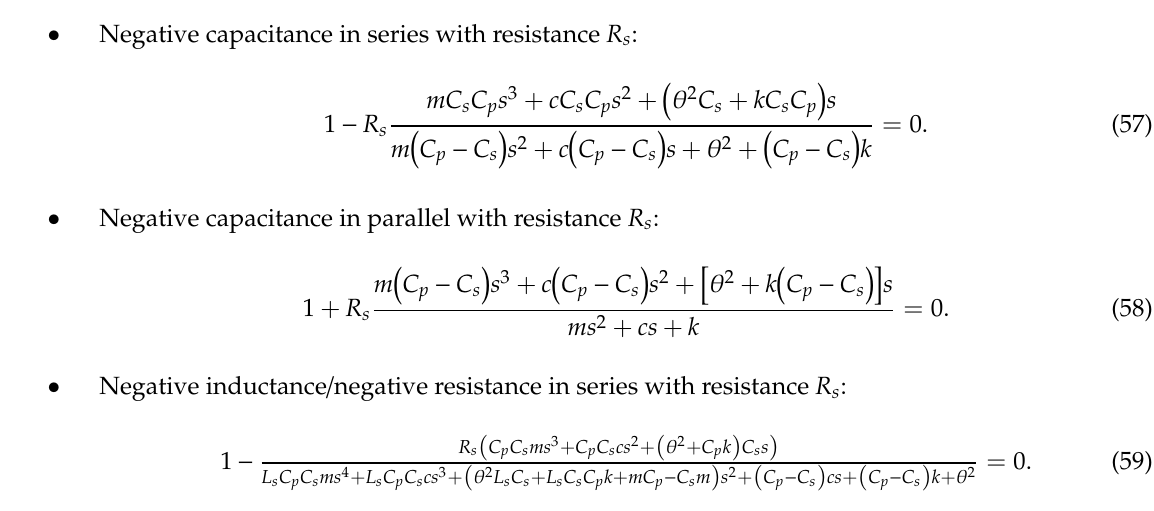
Figure 11. Root locus of the piezoelectric stack transducer with respect to C s for the negative inductance / negative resistance in series with resistance shunt when L s = 10 mH and R s = 50 Ω